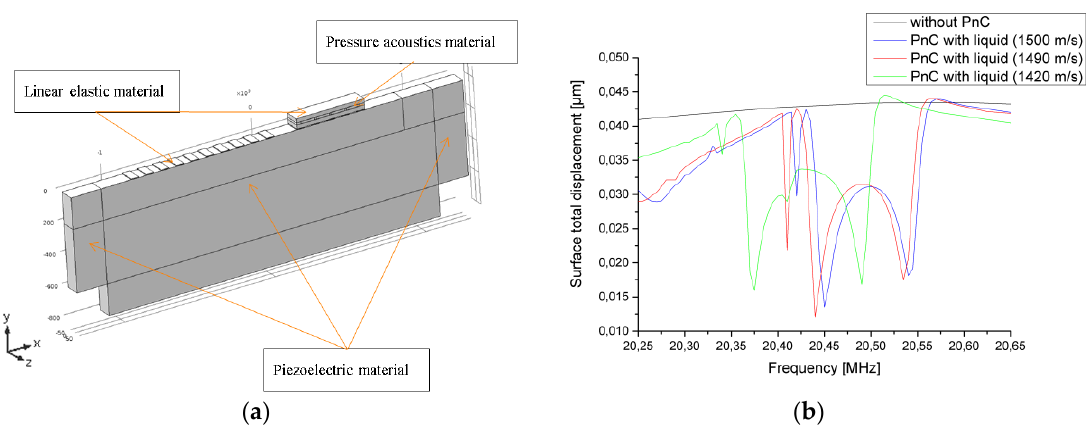
Figure 3. ( a ) Computation model with specified domains; ( b ) Computed structure transmission response obtained as a total displacement taken from the receiving IDTs boundaries for the speed of sound of channels confined liquid of 1500 m/s (orange curve), 1490 m/s (blue curve), 1420 m/s (pink curve), and SAW transmission response without the microfluidic structure (black curve).